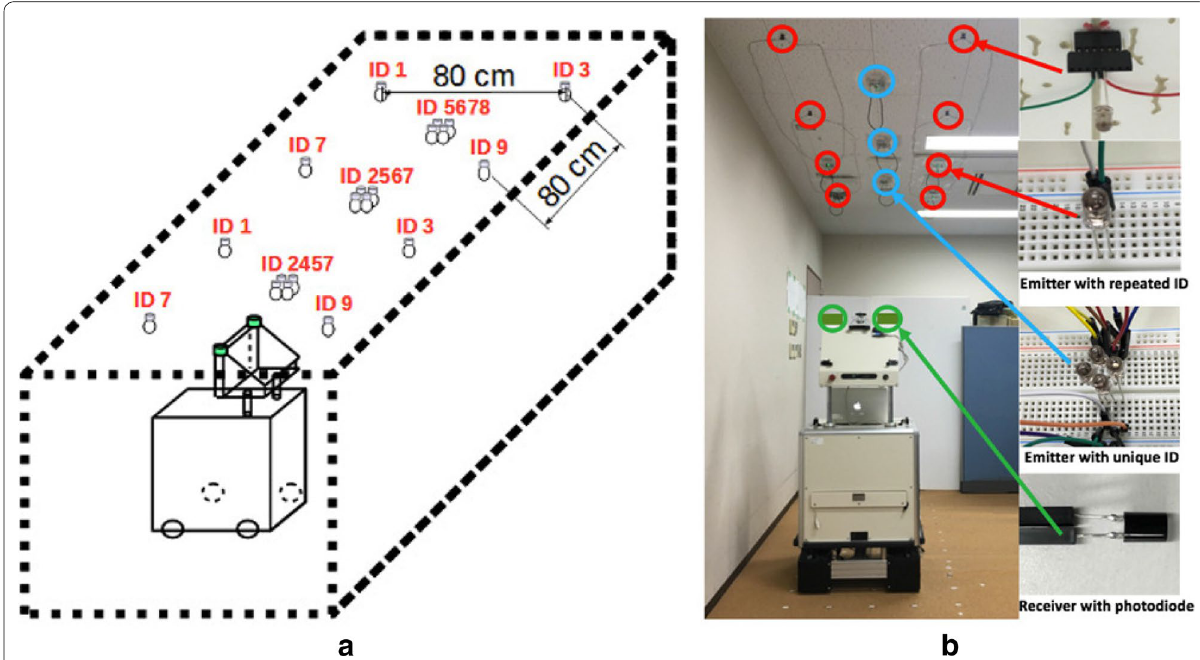
Fig. 7 Experimental environment. a Illustration of the experimental environment; b image of the real experimental environment